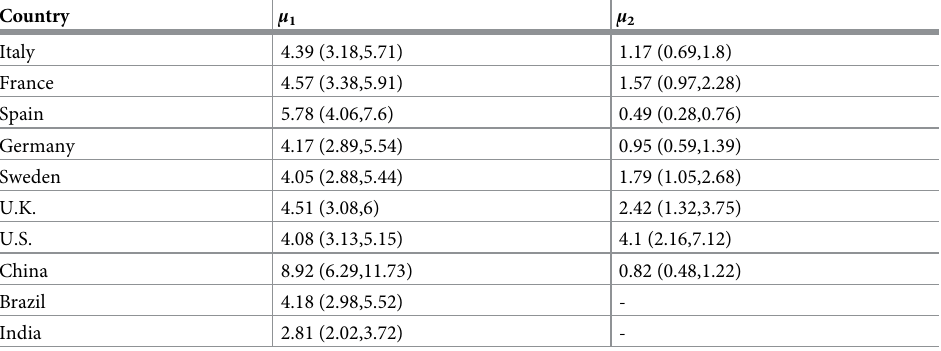
Table 1. Phase 1 versus Phase 2 median and 80% intervals for baseline parameters, μ 1 and μ 2 .